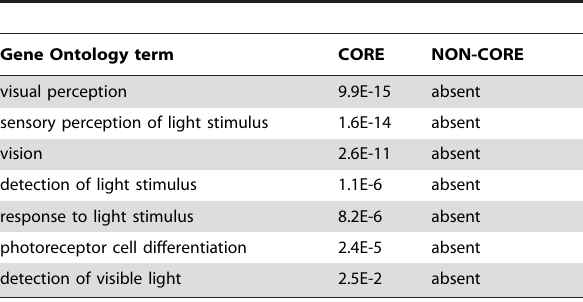
Table 2. Ontology term enrichment in core and non-core set of the